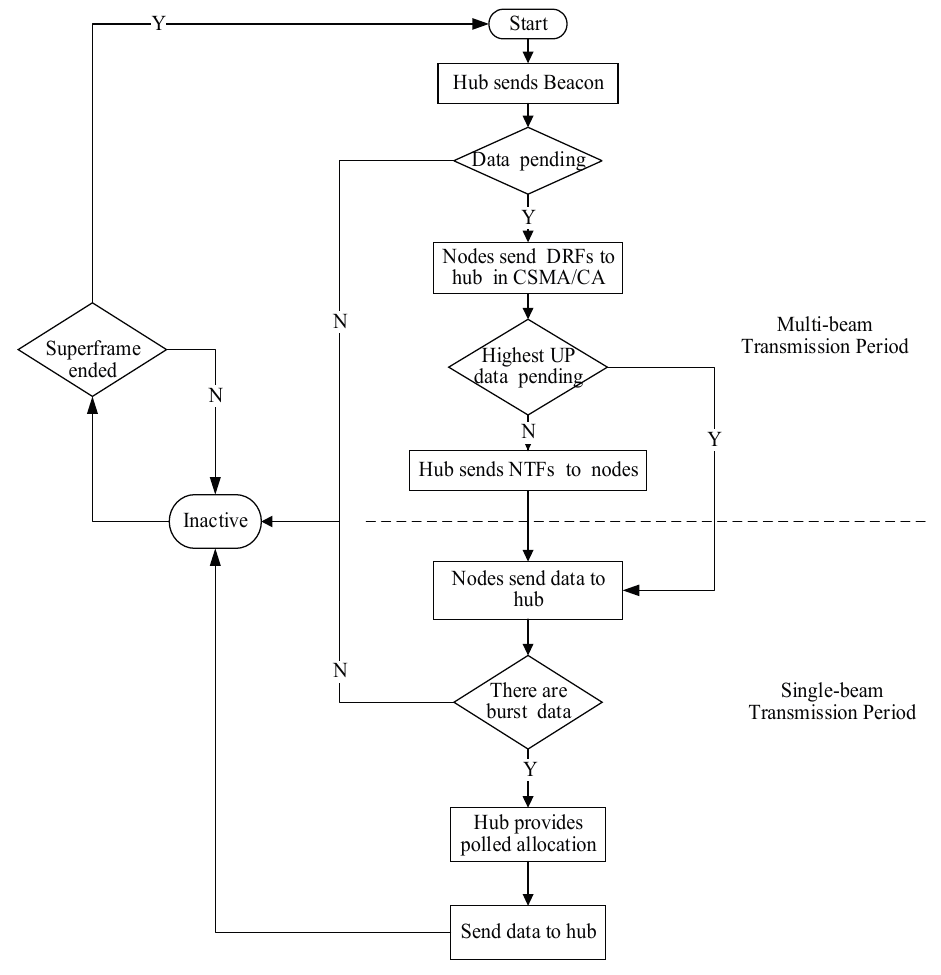
Figure 11. Flowchart of LEDA MAC